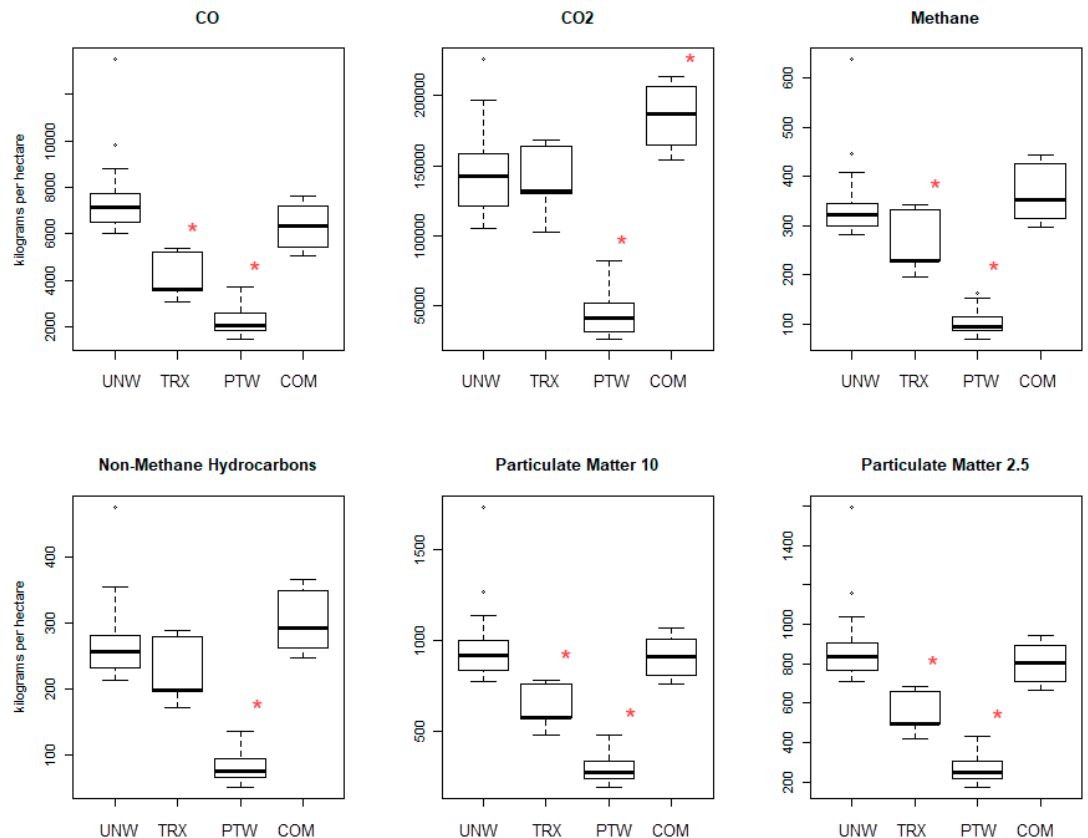
Figure 4. Box plots indicating modeled emission results for specific pollutants for all stands given